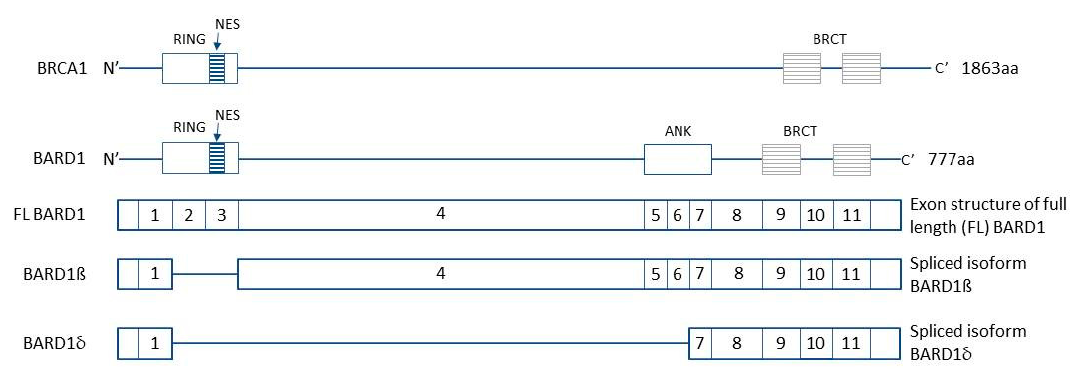
Figure 1. Schematic structures of BRCA1 , BARD1 , and isoforms: BARD1 β , BARD1 δ . RING finger domains enable to form a stable complex between BRCA1 and BARD1 . NES are nuclear export signals which together with NLS (nuclear localization signals) are necessary for proper intracellular localization of BARD1 . ANK (Ankyrin repeats) interacts with several proteins including p53 and NF- κ B. BRCT ( BRCA1 carboxy-terminal domain) motifs fold into a binding pocket with a key lysine residue (K619). The BARD1 - BRCA1 heterodimer, as an E3 ubiquitin ligase, is essential in numerous